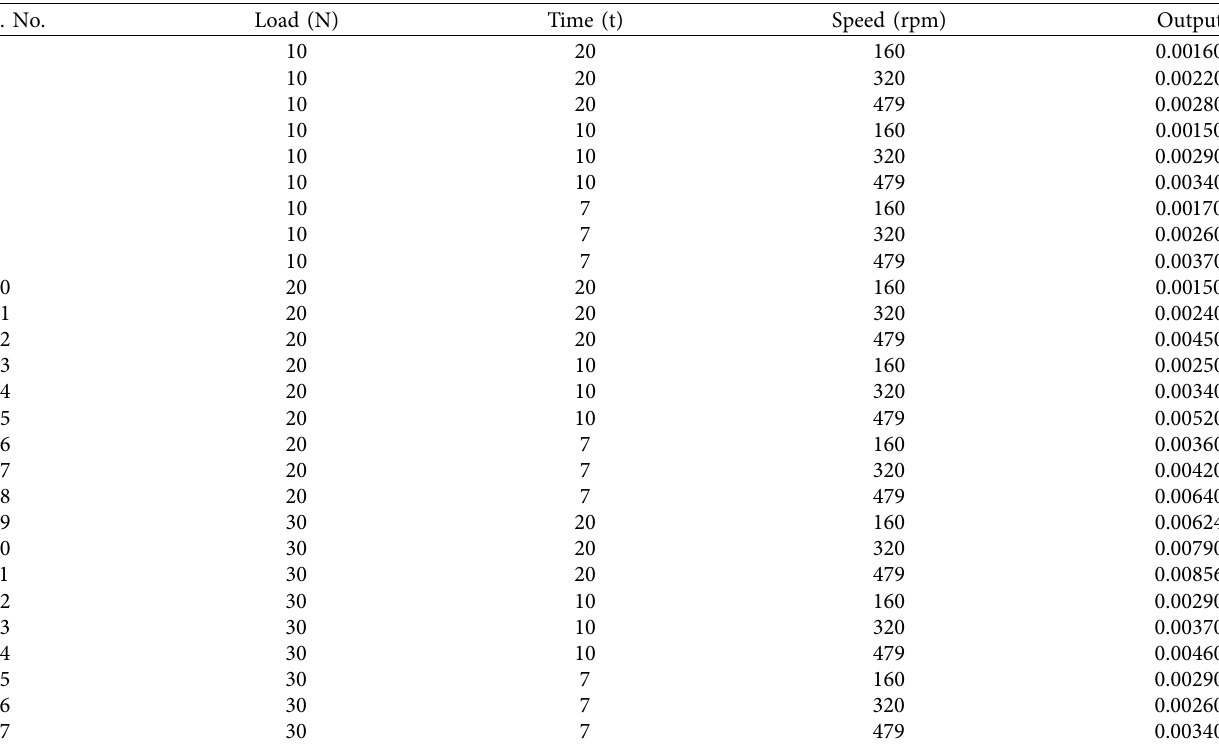
Table 4: Experimental observation for dry sliding wear